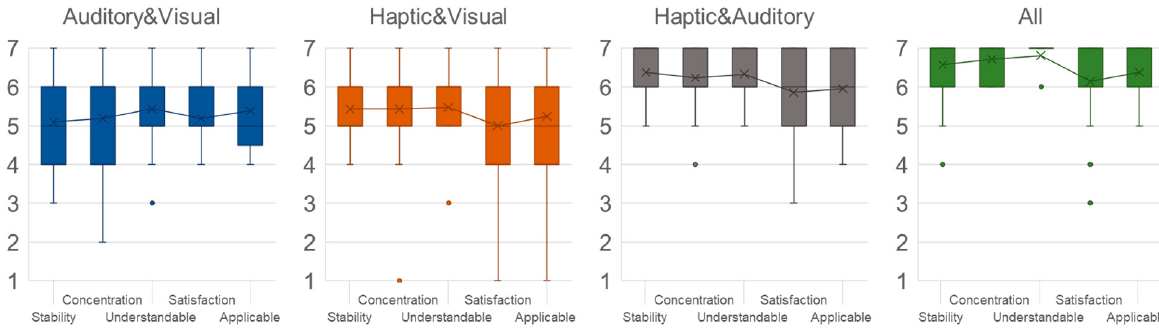
= 89, n = 62, n = 87, n = 139). H & V A & V H & A all